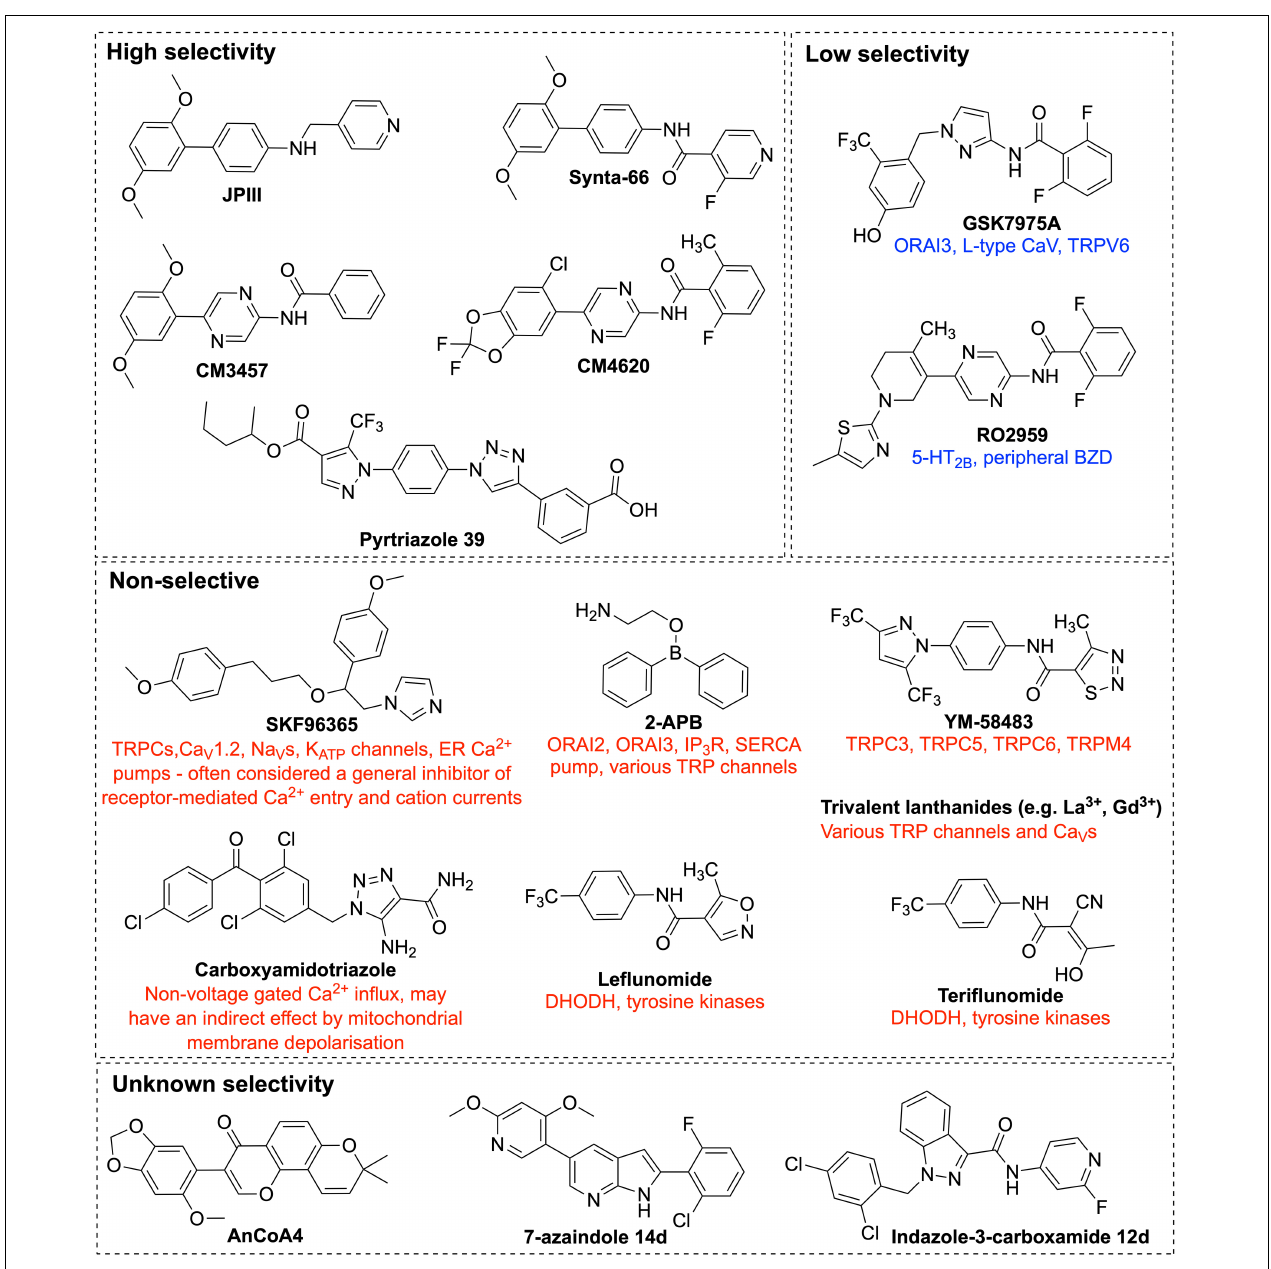
FIGURE 5 | Chemical structures of ORAI1 channel pharmacological inhibitors. Illustration of the chemical structures of ORAI1 channel inhibitors and a list of their previously reported off-targets. The ORAI1 inhibitors were grouped by their reported specificity against ORAI1. 2-APB, 2-Aminoethyldiphenyl Borate; TRP, transient receptor potential; 5-HT 2 B , 5-hydroxytryptamine receptor 2B; BZD, benzodiazepine receptors; DHODH, dihydro-orotate